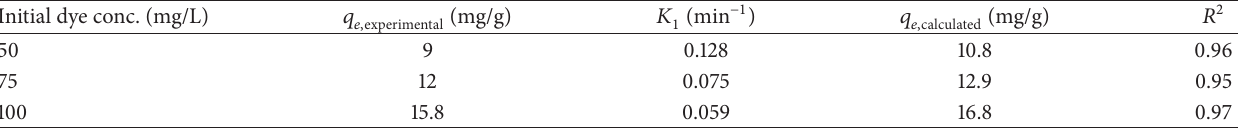
Table 3: Parameters calculated from pseudo-first-reaction kinetic equation for basic violet 16 onto composite sheet matrix. Initial dye conc. (mg/L)